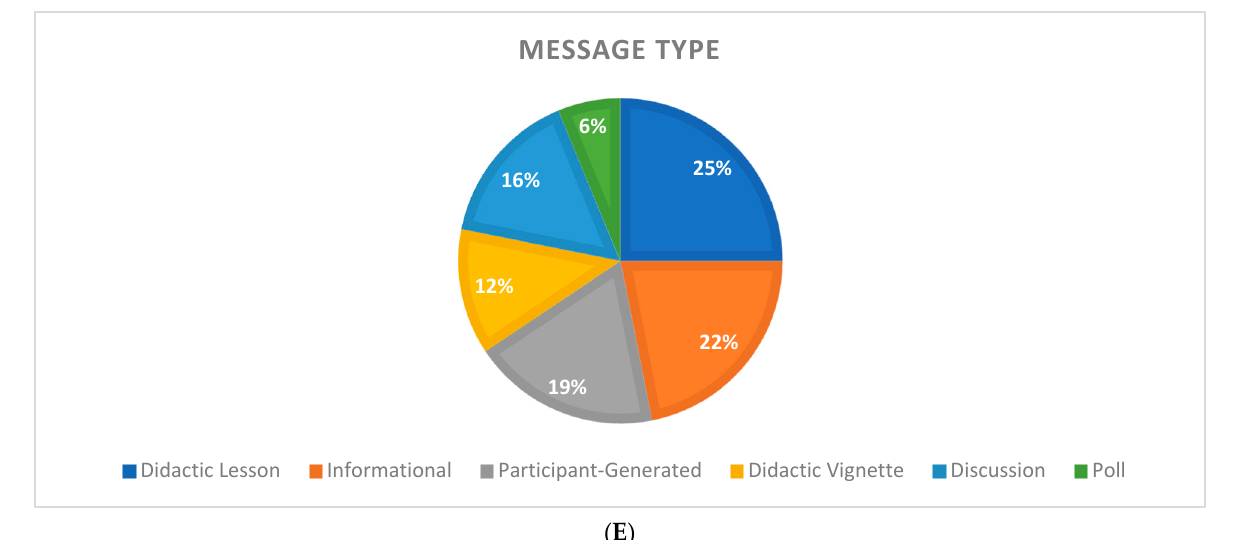
Figure 4. Frequencies of each coded variable across all Input Factors. (Panel A ): Message Source (“we”, participant, “I”). (Pane B ): Message Channel (paragraph, video, picture). (Panel C ): Message Theme (diet, physical activity, lifestyle, reminder). (Panel D ): Message Intent (click, share, react). (Panel E ): Message Type (didactive lesson, informational, participant-generated, didactive vignette, discussion, poll).